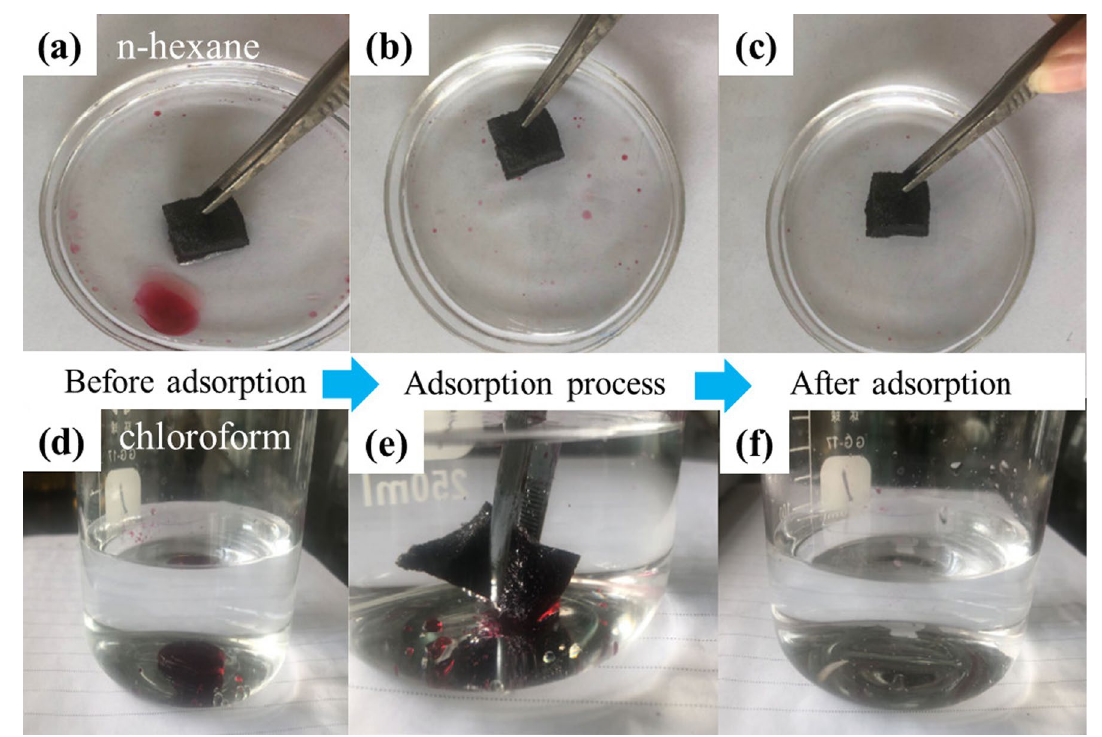
Fig. 5 Adsorptive performance of BC/PU-5 foam composites for n-hexane ( a - c ) and chloroform ( d - f ) (foam sample of 1 g, OSs concentration 100 mg·L −1 , 30 ℃ , and pH